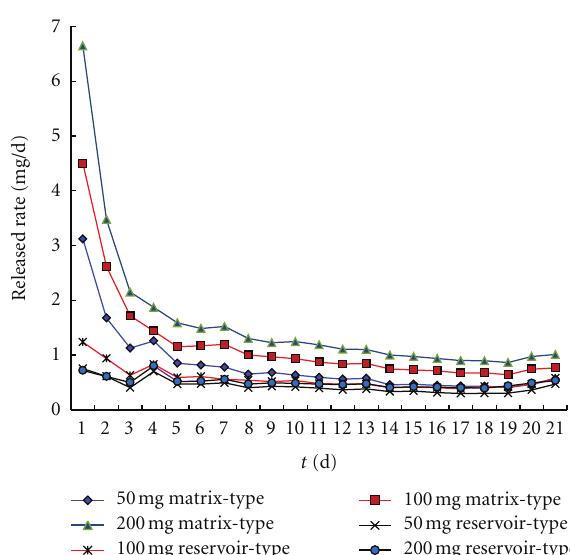
F 7: e in�uence of matrix-type and reservoir-type IVR on the release pro�le of drospirenone.